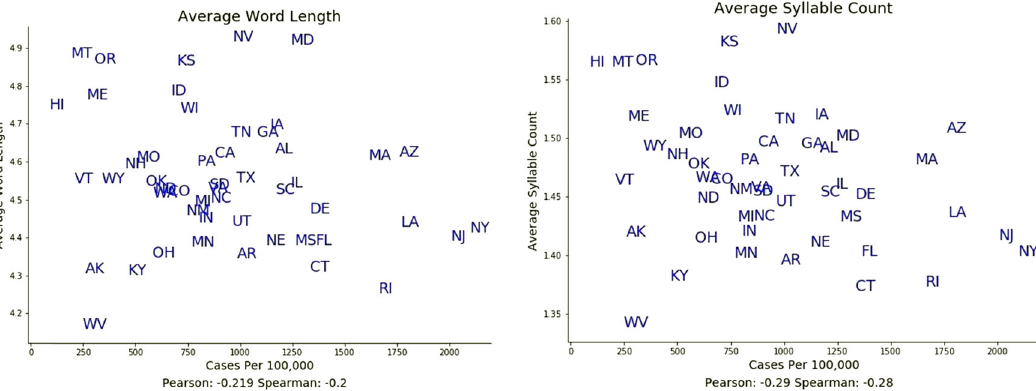
Fig. 7 Spatial associations of linguistic complexity measures with COVID-19 case rates. Both word length and syllable count were negatively associated with COVID-19 case rates over space. The drop in word length and syllable count is particularly noticeable in states with the highest COVID-19 case rates. States are represented by standard two-letter